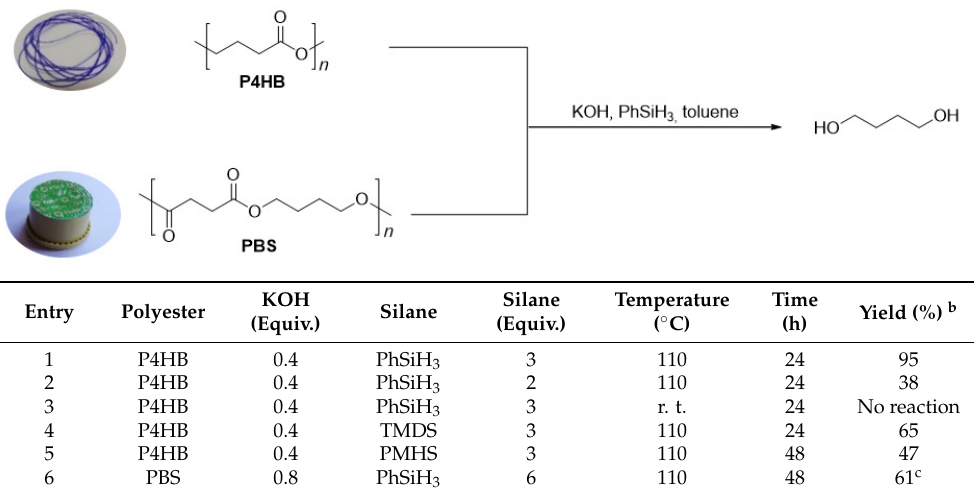
Table 3. Reductive depolymerization of P4HB and PBS with the system KOH/PhSiH 3 a .